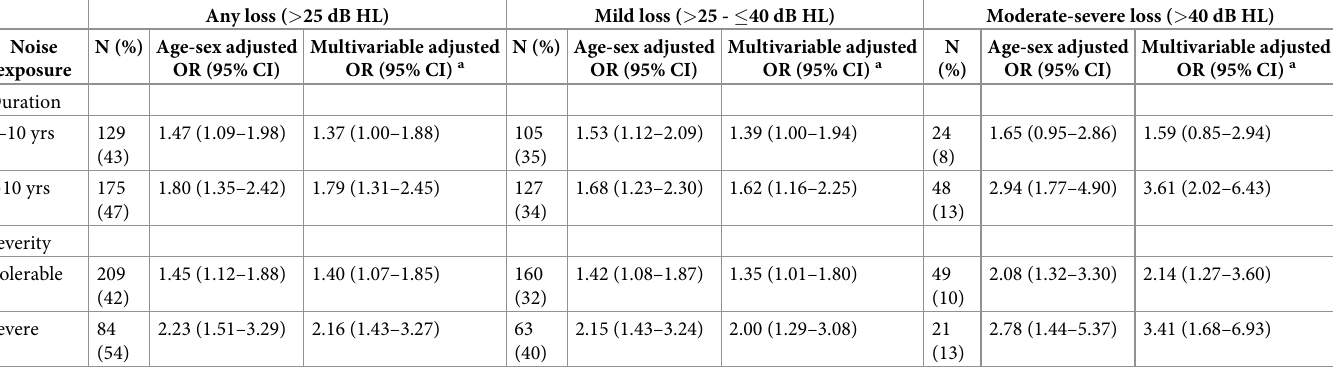
Table 1. Association between severity and duration of exposure to workplace noise and prevalent hearing loss, presented as Odds Ratio (OR) and 95% Confidence Interval (CI).